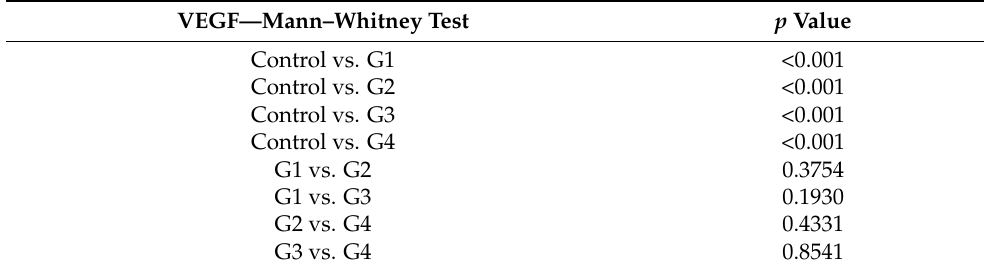
Table 2. Immunohistochemistry analysis of results immunomarked sections with VEGF—through the statistical comparison test through the Mann–Whitney test with a significance level of 5% ( p ≤ 0.05).